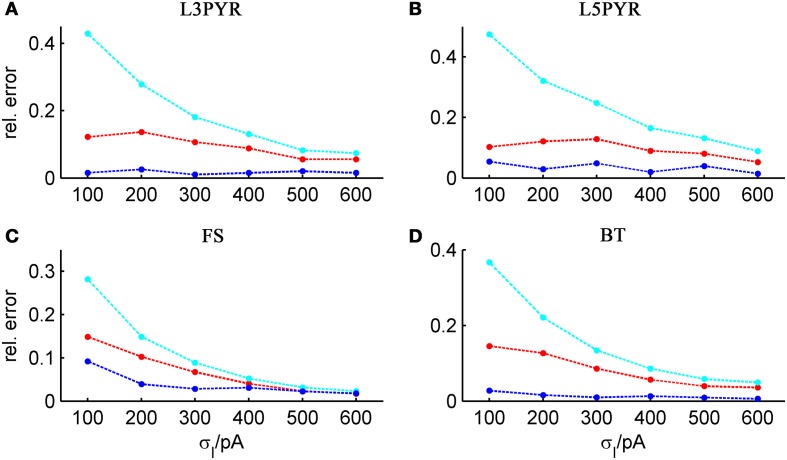
Average relative prediction error as a function of synaptic input standard deviation σIsyn for different neuron types. For the 4 averaged neuron type parameters (A: layer-3 pyramidal cell, B: layer-5 pyramidal neuron, C: fast-spiking and D: bitufted interneuron), the averaged prediction error (Equation 32) is shown in dependence on the input fluctuations σIsyn, evaluated at the cell-specific rheobase μIsyn, for the three derived firing rate approximations (ν0: cyan, ν0 + ϵ2 ν2: blue, 〈 νEIF 〉w: red). Relative prediction error averaged across b = [15, 30, 50, 80] pA.